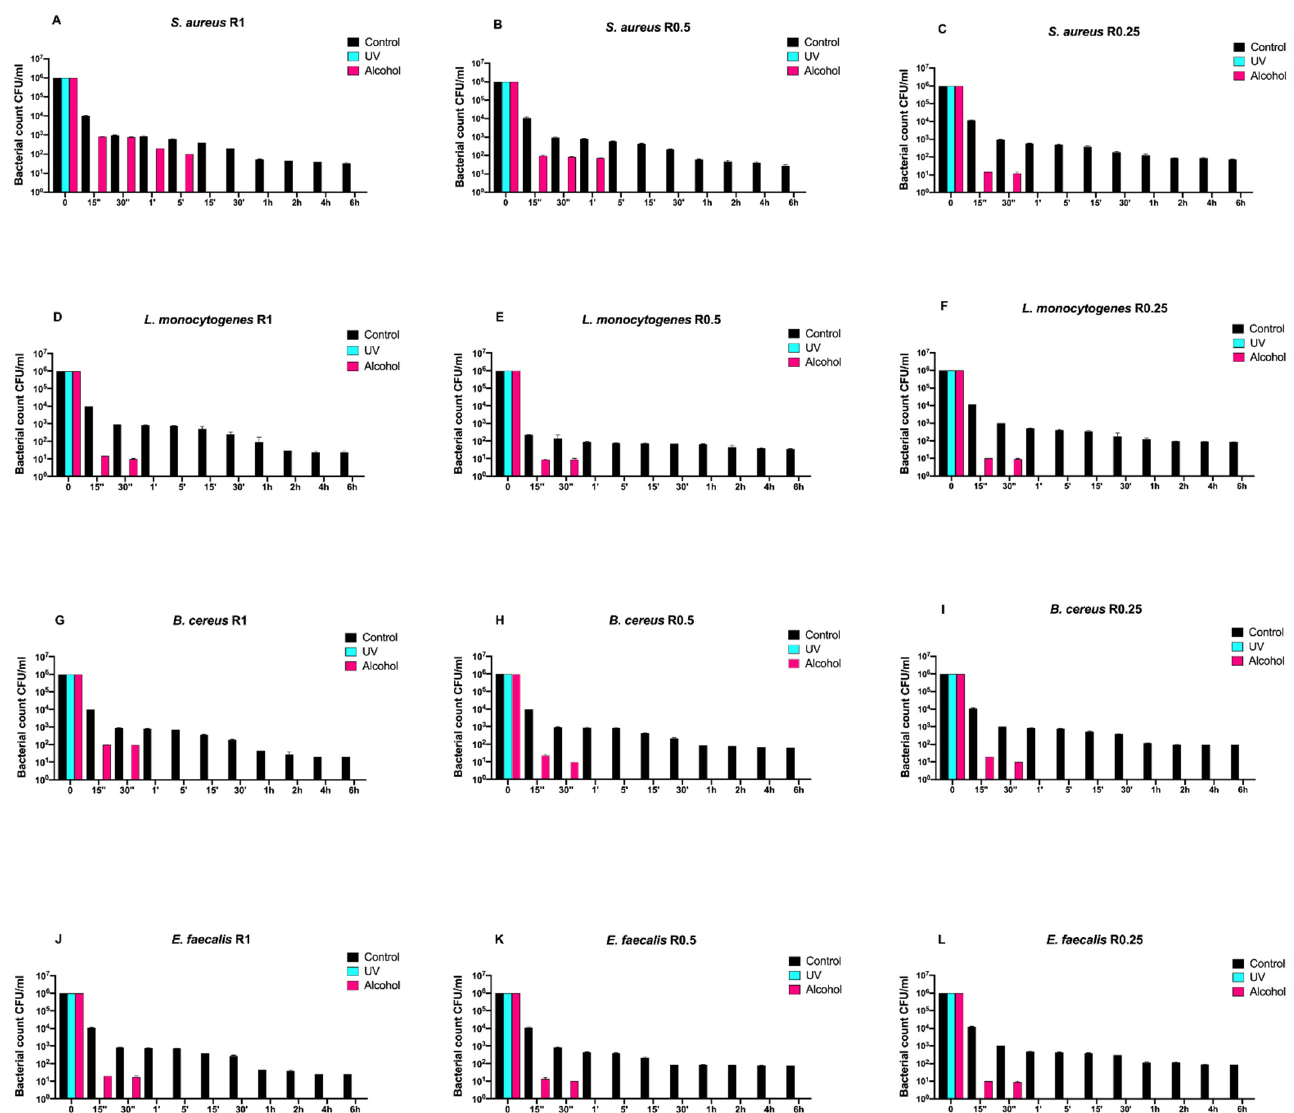
Figure 4. Graphical representation of the different exposure times of SiO x C y H z -coated disks with different surface rough- ness (R0.25, R0.5, and R1) unsanitized (control) and subjected to two sanitizing methods (UVC and alcohol) against ( A – C ) Staphylococcus aureus ATCC 6538 , ( D – F ) Listeria monocytogenes NCTT 10888, ( G – I ) Bacillus cereus ATCC 14579 and ( J – L ) Enterococcus faecalis ATCC 29212 .